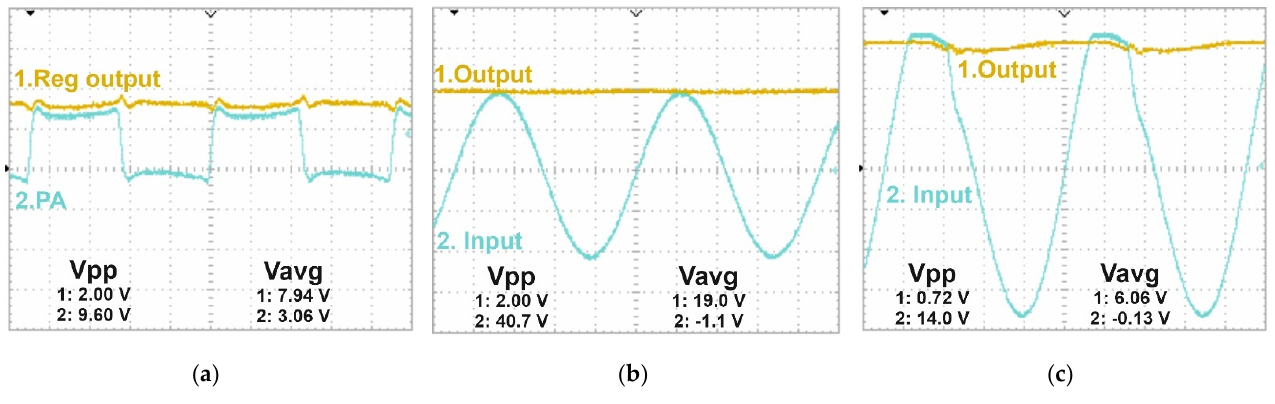
Figure 7. ( a ) Voltage regulator and PA waveform. ( b ) Input and no-load output voltage of rectifier. ( c ) Input and output voltage to the 82 Ω load of rectifier (shown in the schematic of Figure